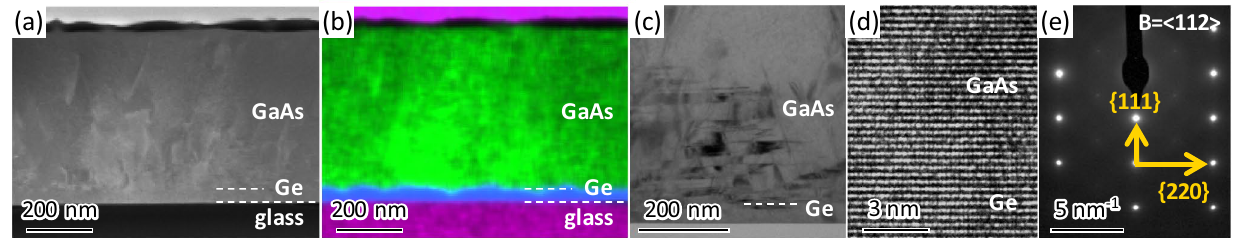
Figure 5. Cross-section characterization of sample in Group D ( t AE = 3 min). ( a ) High-angle annular dark-field scanning TEM image. ( b ) EDX elemental map. ( c ) Bright-field TEM image. ( d ) High-resolution lattice image showing GaAs/Ge interface. ( e ) SAED pattern obtained from region including GaAs and Ge layers with selected area of diameter 800 nm.